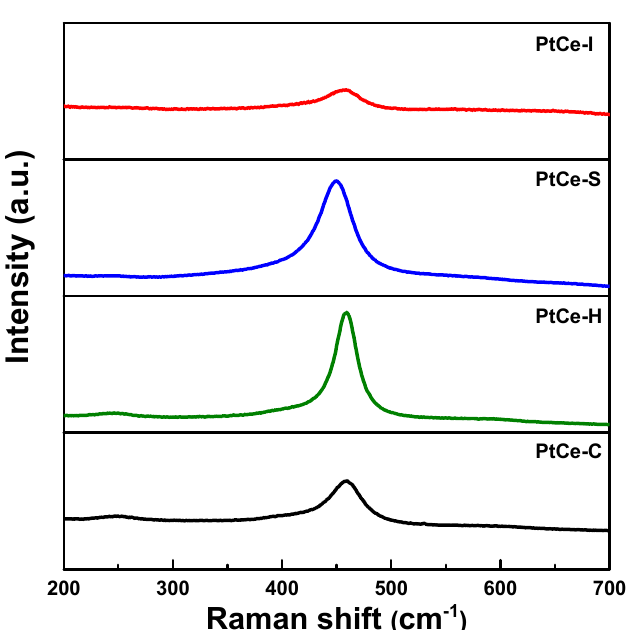
Figure 4. Raman spectra of reduced CeO 2 -supported Pt catalysts prepared by various synthesis methods.